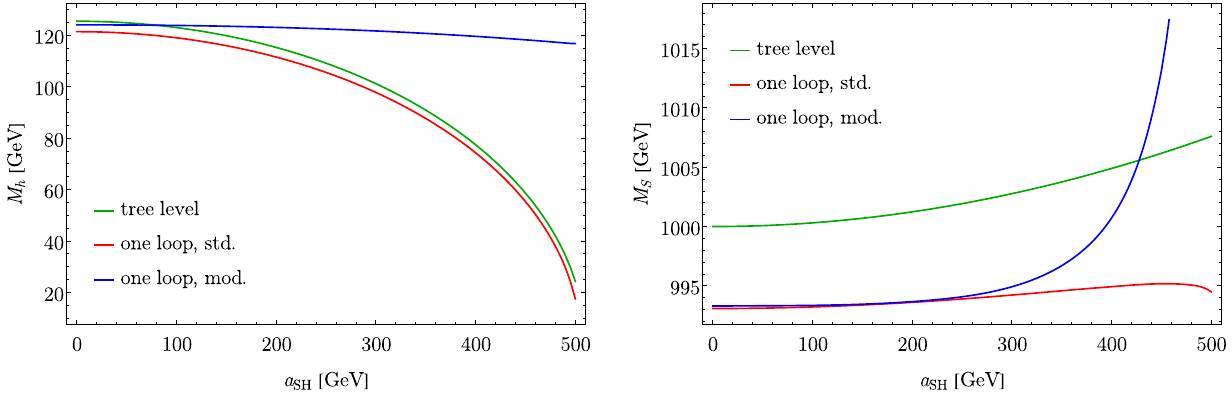
= 1000 GeV, Q = 5000 GeV, a S